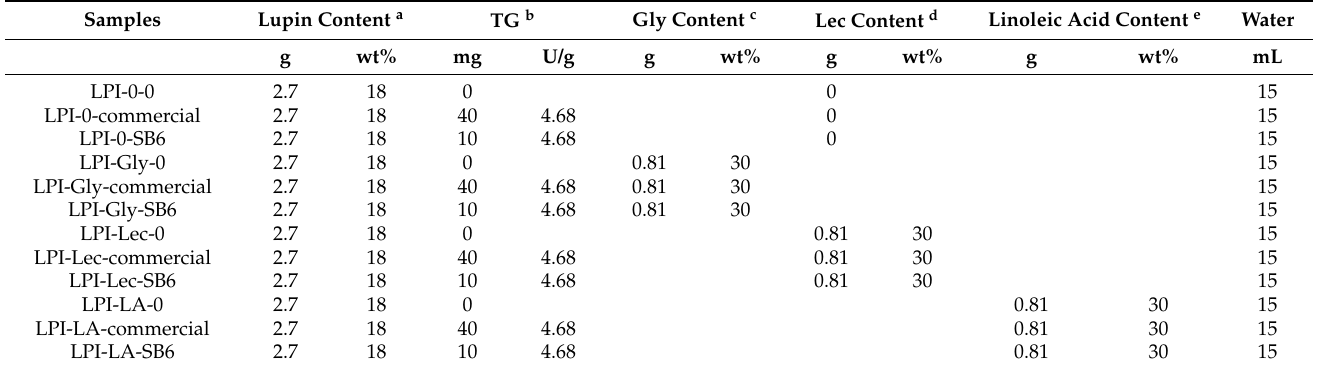
Table 2. Composition of solid lupin foams consisting of diverse additives